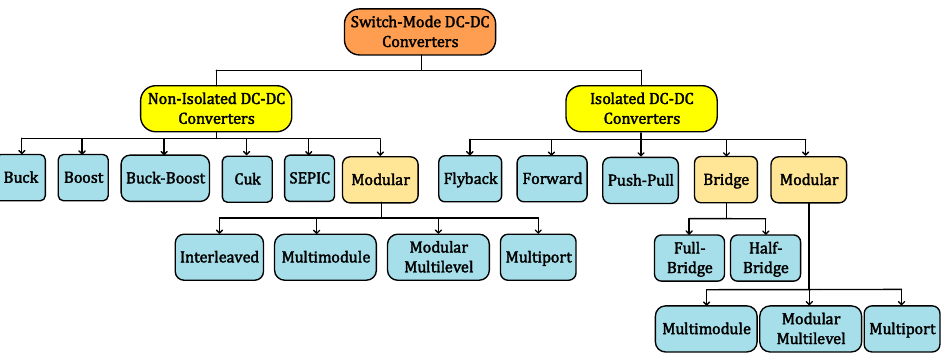
Figure 4. Switch-Mode DC-DC converters classification.